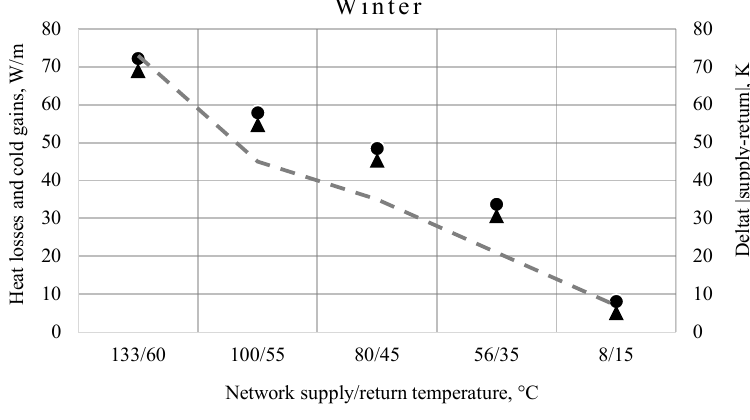
Fig. 3. Calculated heat losses – winter